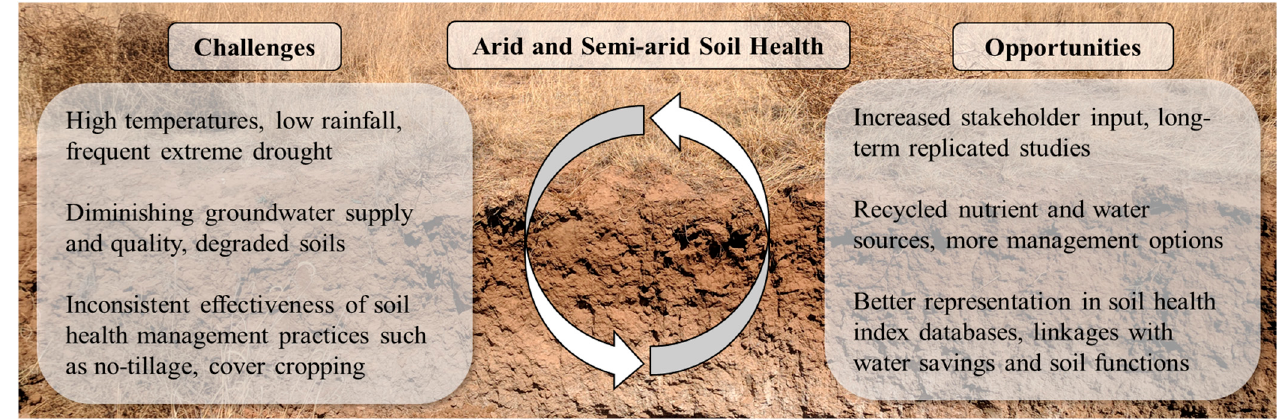
Figure 4. Challenges and opportunities of soil health assessment and management in arid and semi- arid (water-limited) environments of the western United